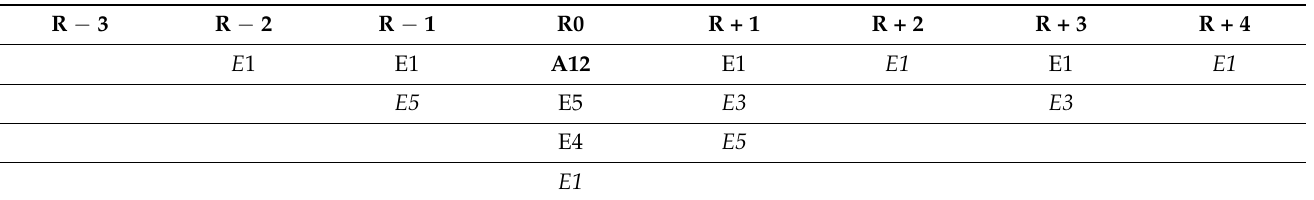
Table 3. Conditioned behaviors associated with confused expression of emotions (A12).